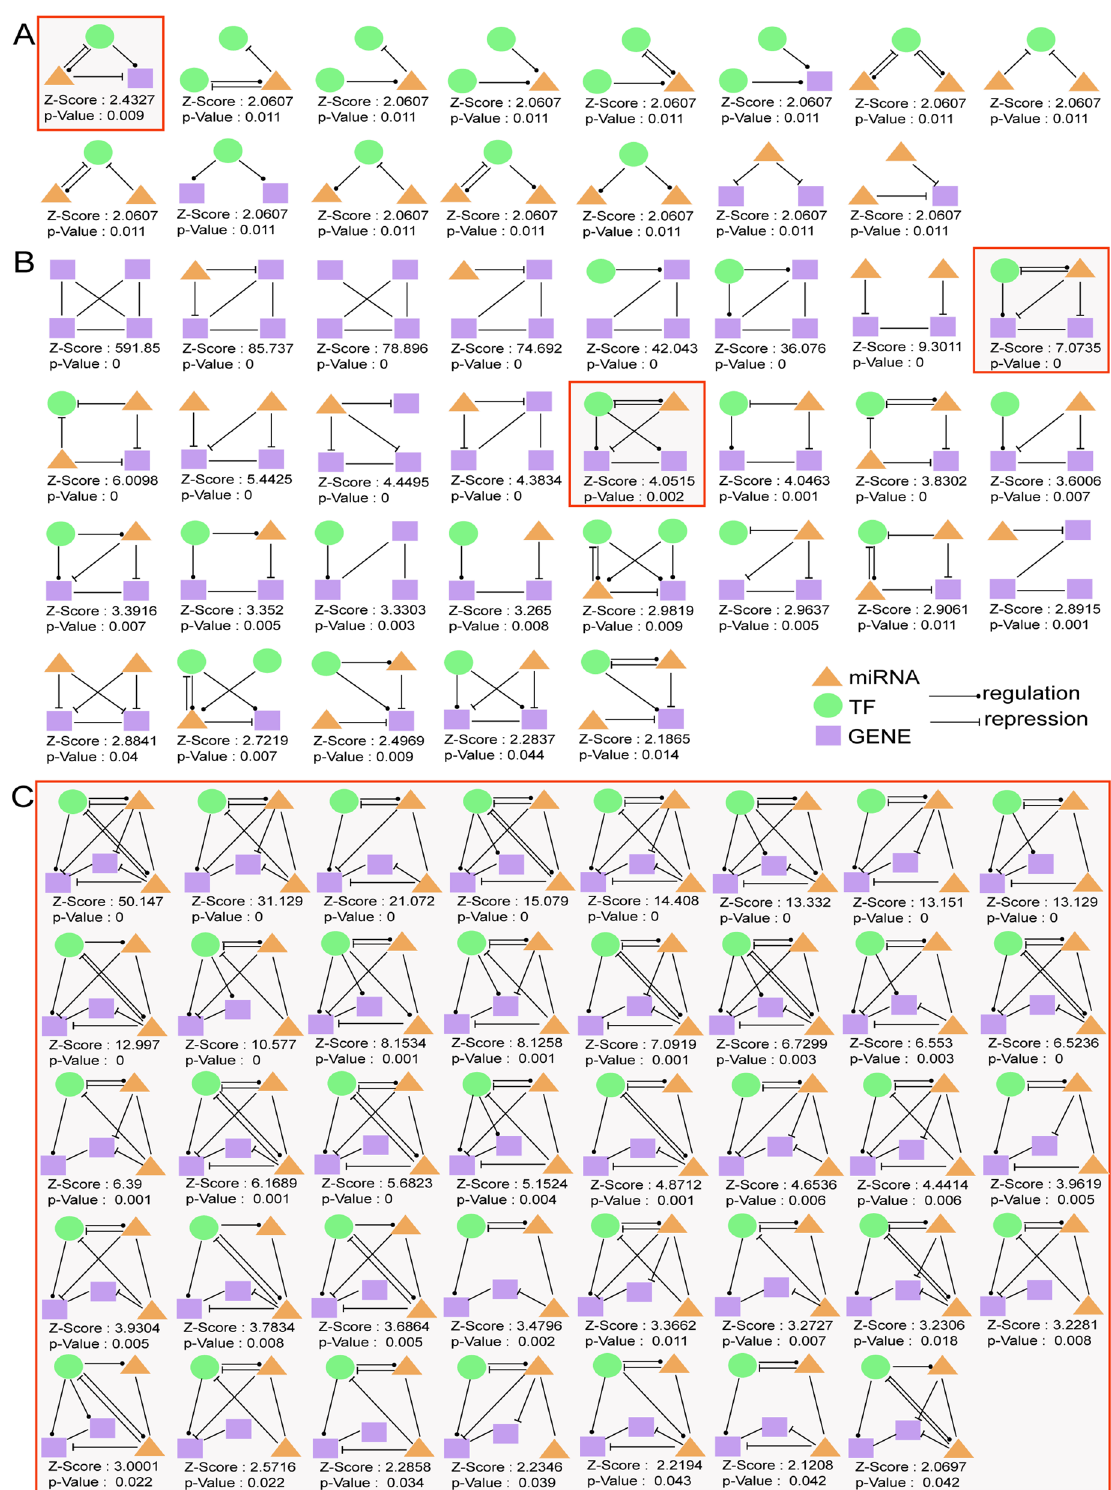
Figure 2. 3-node, 4-node and 5 node motifs. ( A ) 15 different types of 3-node regulatory motifs. ( B ) 29 different types of 4-node regulatory motifs. ( C ) 39 screened different types of 5-node regulatory motifs. The motifs are composed of miRNAs, TFs, and target genes and their Z-scores and p value s are presented. Orange triangles represent miRNAs, green rounds represent TFs and purple squares represent genes. An arrow ending in a circle represents the regulatory relationship, while, an arrow ending in a “T” represents the repression relationship. Six types of relationships involved in these motifs: miRNA–gene (miRNA represses gene expression); miRNA–TF (miRNA represses TF gene expression); TF–miRNA (TF regulates miRNA expression); TF–gene (TF regulates gene expression); gene–gene (gene and gene interaction); and miRNA–miRNA (miRNA and miRNA interaction). Motifs surrounded by red squares (3-node, 4-node and 5-node composite feed-forward loop) as significant motifs were merged to form 3-node, 4-node and 5-node regulatory sub-networks, respectively. TF: transcription factor; FFL: feed-forward